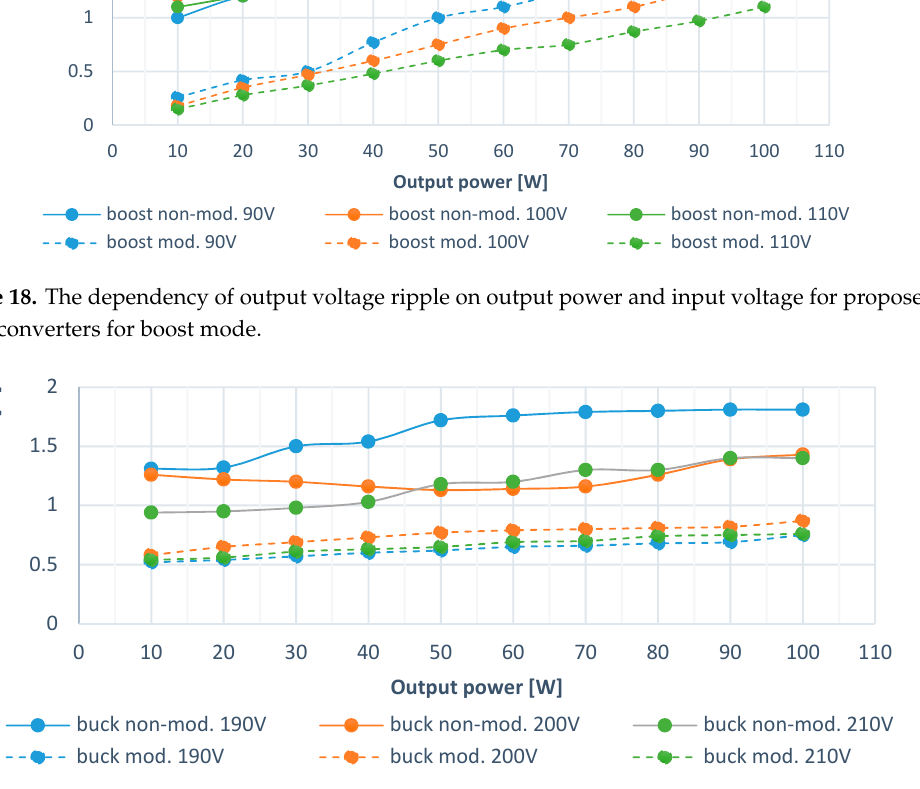
Figure 19. The dependency of output voltage ripple on output power and input voltage for proposed bi-BB converters for buck mode.